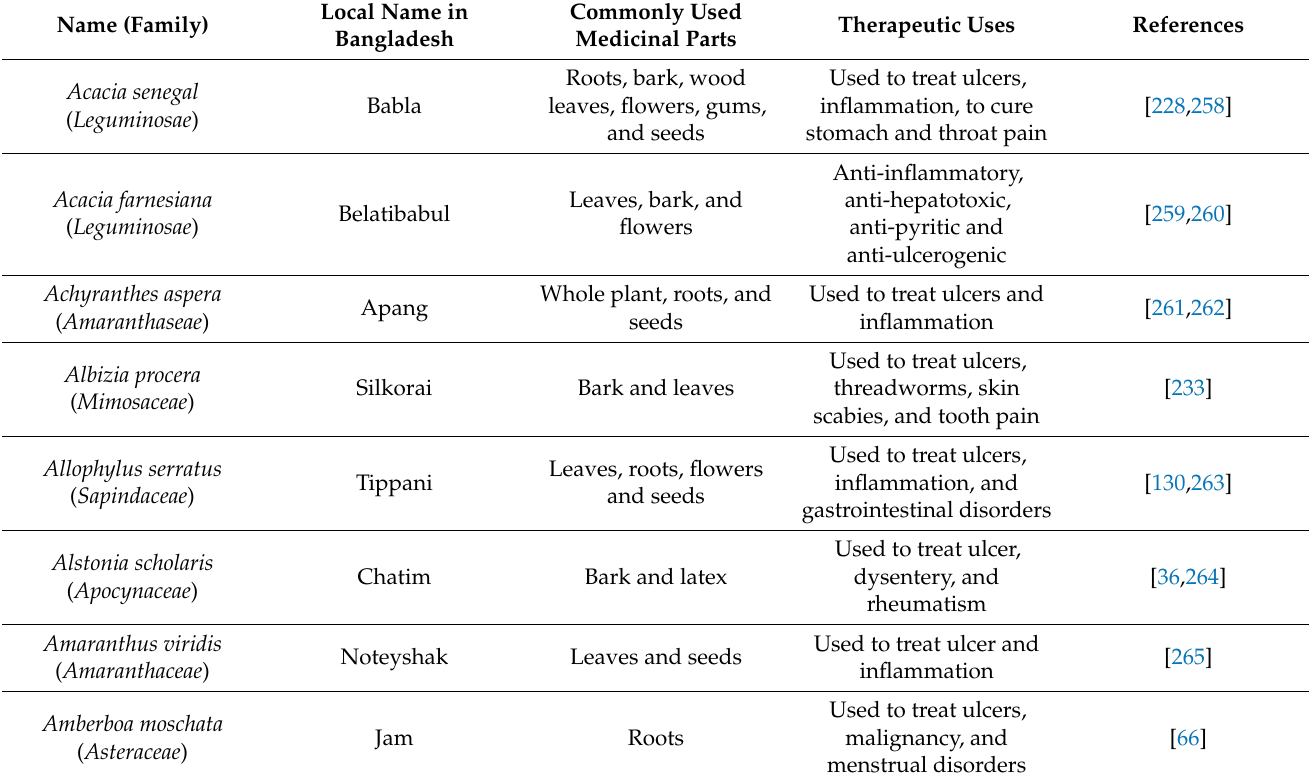
Table 1. Common medicinal plants of Bangladesh used in the treatment of ulcer, inflammatory, and other related diseases. Name